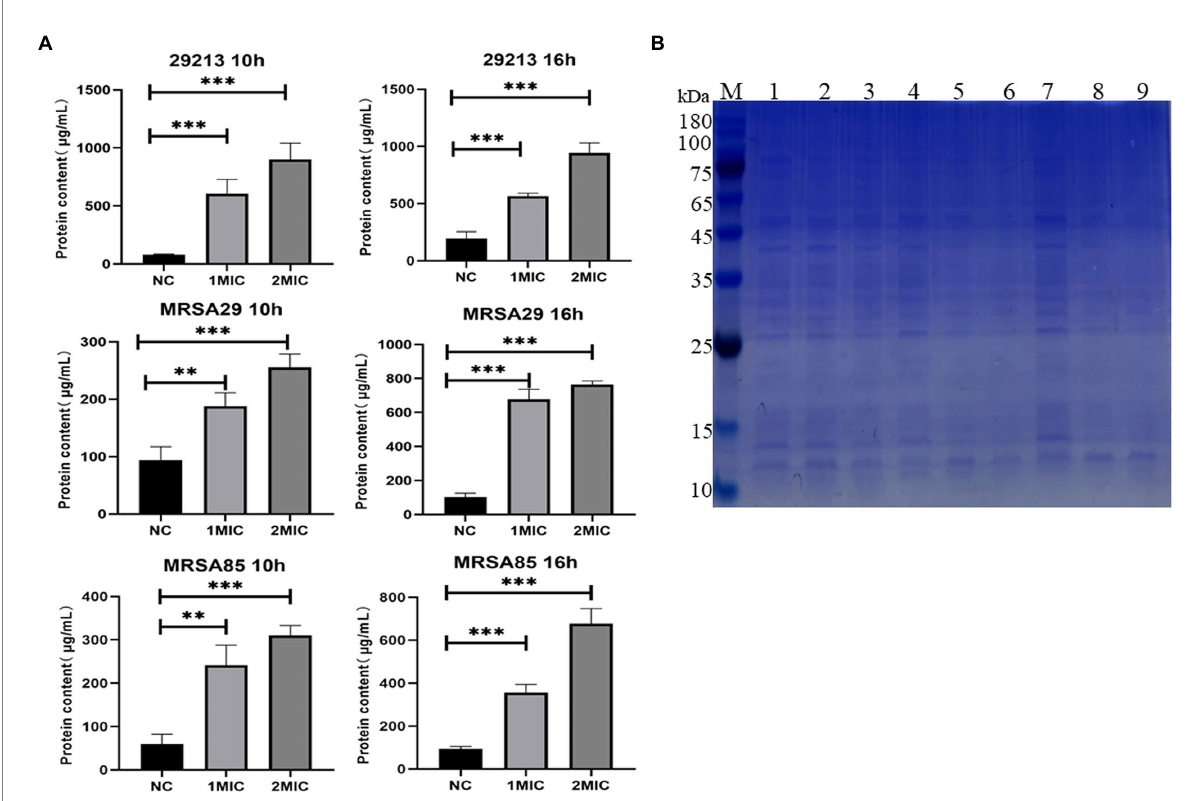
FIGURE 4 Organic acid of Portulaca oleracea L. (OAPO) increases the soluble protein content of bacterial culture solution. (A) The soluble protein content of Staphylococcus aureus (29,213, MRSA29, and MRSA85) at 10 and 16 h post-treatment with 1× and 2× minimum inhibitory concentration (MIC) of OAPO was determined by the BCA kit. *indicates p < 0.05, **indicates p < 0.01, ***indicates p < 0.001 when compared with the negative control group (NC, untreated with OAPO). (B) Sodium dodecyl sulfate-polyacrylamide gel electrophoresis (SDS-PAGE) of bacterial cells treated with OAPO. M: Marker, Lane 1/4/7: 29213, Lane 2/5/8: MRSA29, Lane 3/6/9: MRSA85; Lane 1/2/3: treated with two-fold MIC of OAPO, Lane 4/5/6: treated with one-fold MIC of OAPO, Lane 7/8/9: untreated with